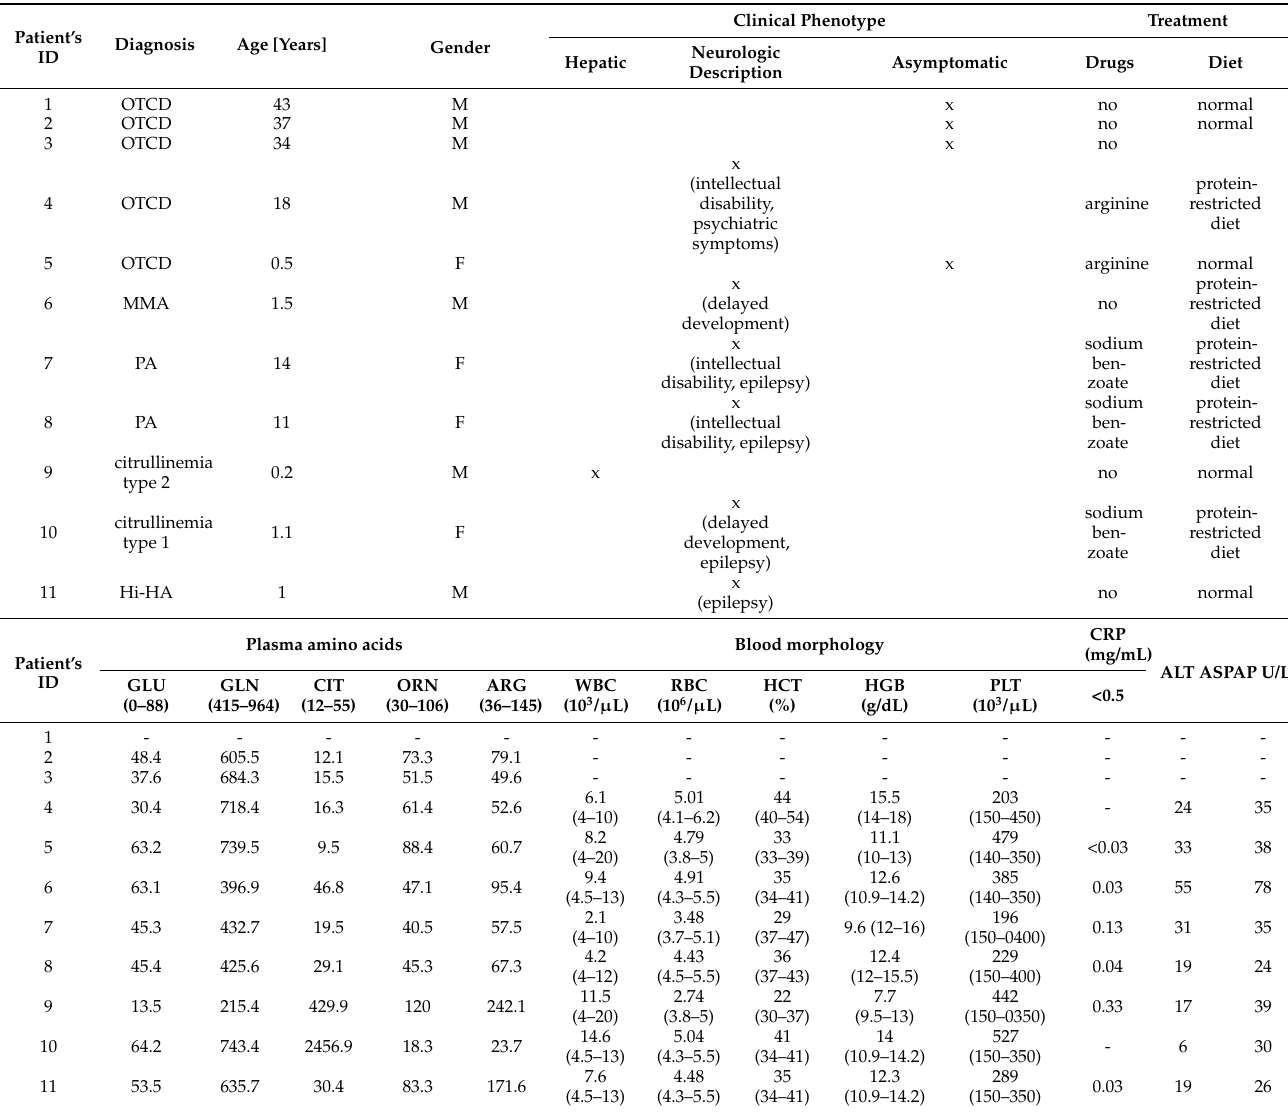
Table 1. Clinical characteristics of patients 1